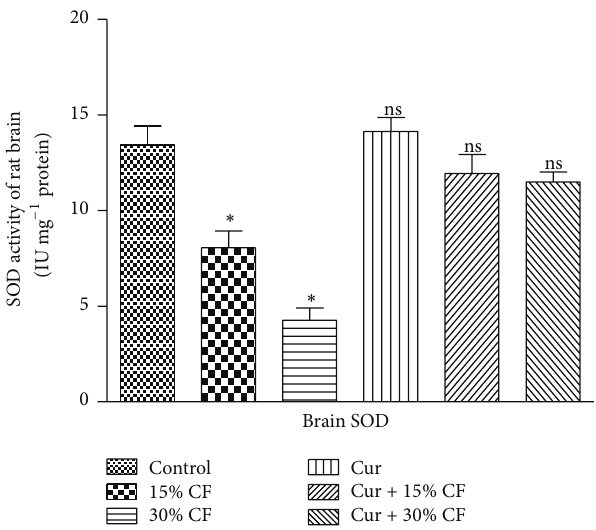
Figure 1: Effects of carbofuran and curcumin on the activity of SOD in the brain stem of rat. The procedures for the administration of carbofuran and pretreatment with curcumin as well as assay of SOD activity were the same as mentioned in Section 2. The unit of enzyme activity was expressed as IUmg −1 protein. The data represent mean ± SD of 5 independent experiments. ∗ indicates the 𝑃 values significant at < 0.001 and ns refers to nonsignificant at 𝑃 > 0.05 as compared to control